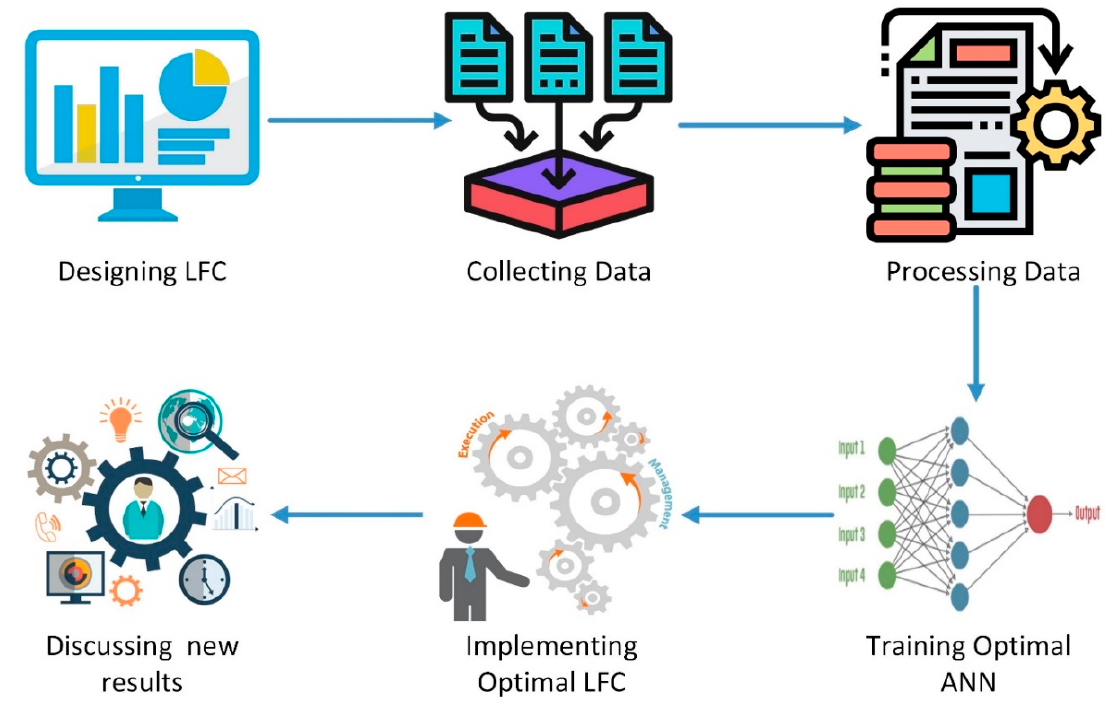
Figure 1. Work strategy procedure.